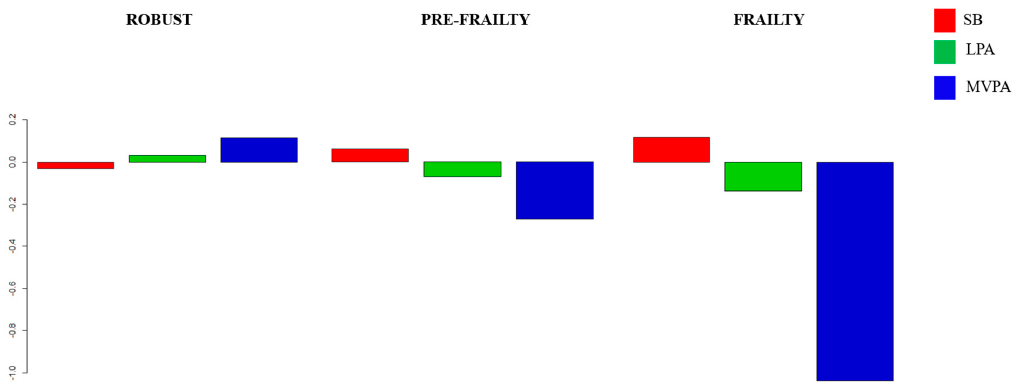
Figure 3. Movement patterns according to frailty status and sex: Compositional geometric mean bar plots comparing the compositional mean of the entire sample with the compositional mean of robust, pre-frail and frail subgroups for sedentary behavior (SB), light intensity physical activity (LPA) and moderate-to-vigorous intensity physical activity (MVPA) for the whole sample.